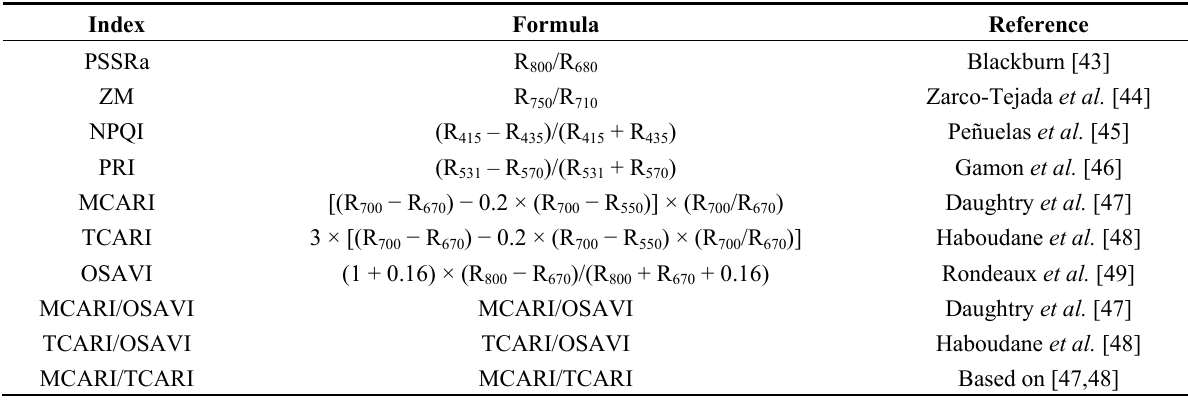
Table 2. Reflectance indices used in this